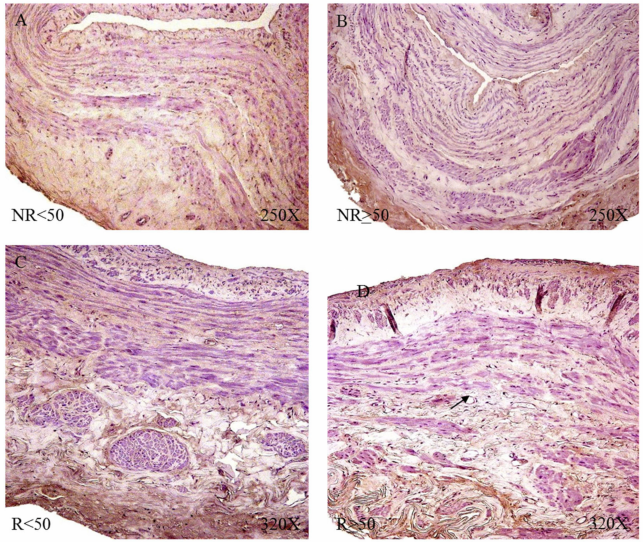
Figure 17. Protein expression of LOX in patients NR < 50 ( A ), NR ≥ 50 ( B ), R < 50 ( C ) and R ≥ 50 ( D ).